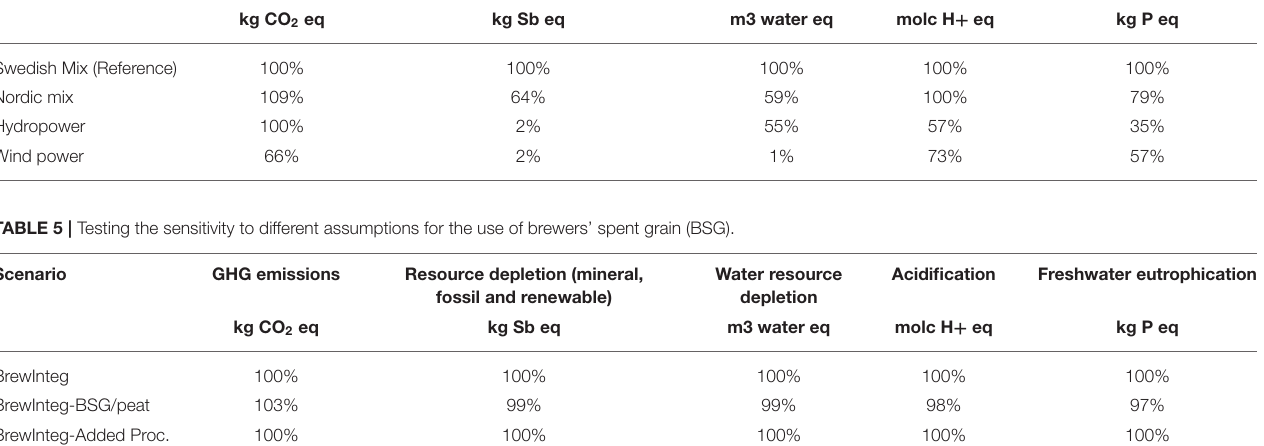
TABLE 4 | Sensitivity to the choice of electricity system employed on the different environmental impacts compared to reference scenario (Swedish), shown in percentage. Electricity source